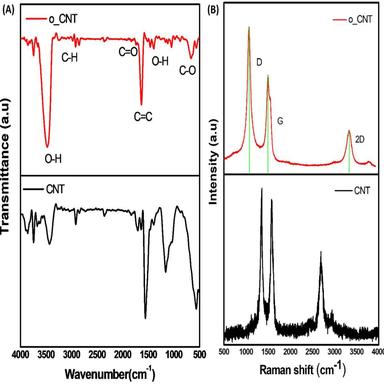
FTIR (A) and Raman spectra (B) of pristine and oxidized MWCNT structures.